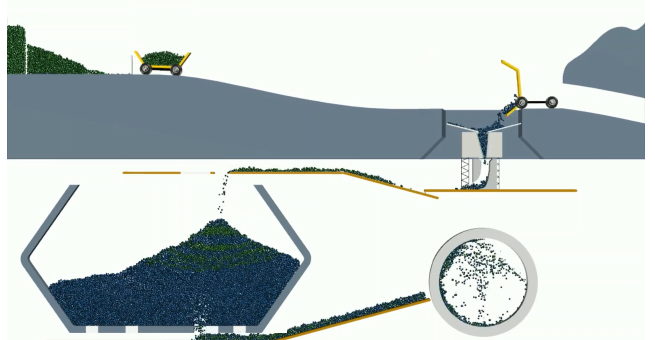
Figure 4. Image from the simulator with material hauled with trucks from two sources, dumped at a jaw crusher, conveyed to and from a storage and, finally, fed to a grinder. Green particles come from the left source and blue particles from the right source. A video is available as Supplementary Material Video S2.